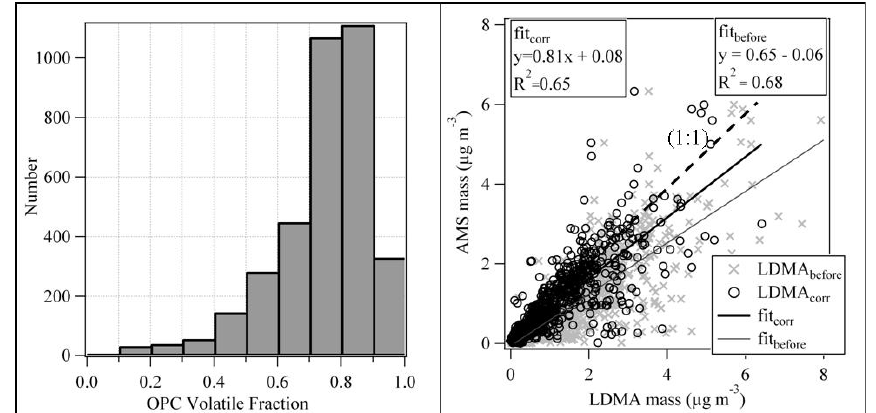
Fig. 2. (Left) Histogram of the volatile fraction established from the OPC. (Right) Relationship between LDMA volatile mass and AMS mass for the VOCALS MBL before and after the non-volatile correction